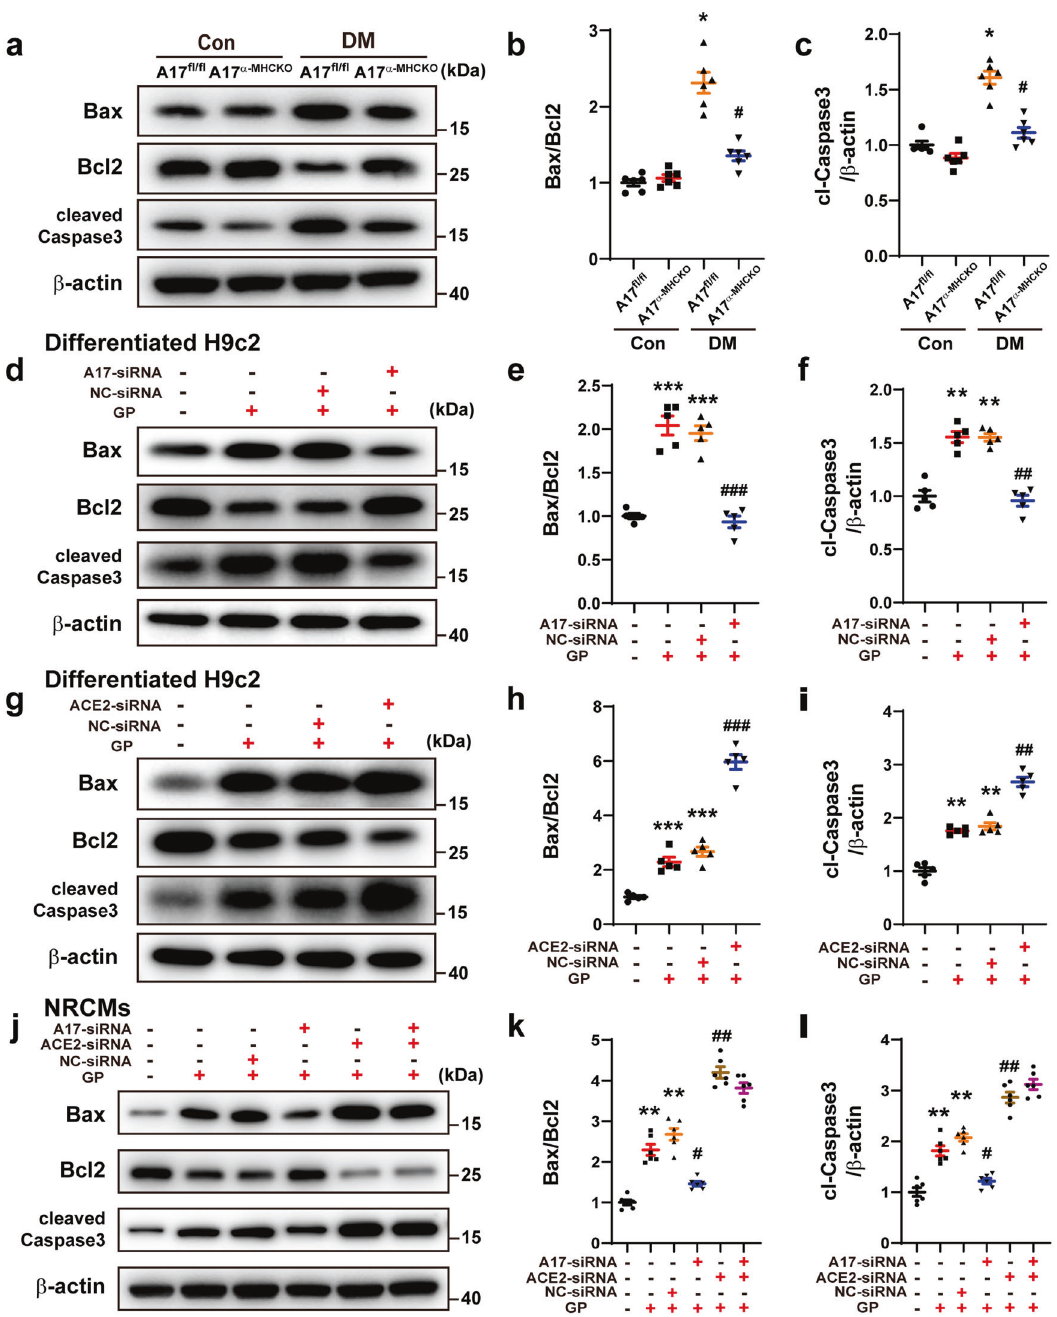
Fig. 3 Effects of ADAM17 and ACE2 on apoptosis in mice, differentiated H9c2 cells and NRCMs. a Representative Western blot images of Bax, Bcl2, and cleaved caspase-3 expression in the myocardium of four groups of mice. b , c Quantitative analysis of Bax/Bcl2 and cleaved caspase-3 expression in four groups of mice, n = 6. Data were shown as mean ± SEM. * P < 0.05 vs. the A17 fl / fl control group; # P < 0.05 vs . the A17 fl / fl DM group. d – f Representative Western blot images of Bax, Bcl2, and cleaved caspase three expression and quantitative analysis of Bax/Bcl2 and cleaved caspase three expression in four groups of differentiated H9c2 cells treated with vehicle, GP, GP + NC-siRNA and GP + ADAM17-siRNA, respectively. Mean values were derived from fi ve independent experiments. g – i Representative Western blot images of Bax, Bcl2, and cleaved caspase-3 expression and quantitative analysis of Bax/Bcl2 and cleaved caspase-3 in four groups of differentiated H9c2 cells treated with vehicle, GP, GP + NC-siRNA and GP + ACE2-siRNA, respectively. Mean values were derived from fi ve independent experiments. Data were expressed as mean ± SEM. ** P < 0.01, *** P < 0.001 vs. the vehicle group; ## P < 0.01, ### P < 0.001 vs. the GP + NC-siRNA group. j Representative Western blot images of Bax, Bcl2, and cleaved caspase-3 expression in six groups of NRCMs treated with vehicle, GP, GP + NC-siRNA, GP + ADAM17-siRNA, GP + ACE2-siRNA and GP + ADAM17-siRNA + ACE2-siRNA, respectively. k , l Quantitative analysis of Bax/Bcl2 and cleaved caspase-3 expression in six groups of NRCMs. Mean values were derived from six independent experiments. Data were presented as mean ± SEM. ** P < 0.01 vs. the vehicle group; # P < 0.05, ## P < 0.01 vs. the GP + NC-siRNA